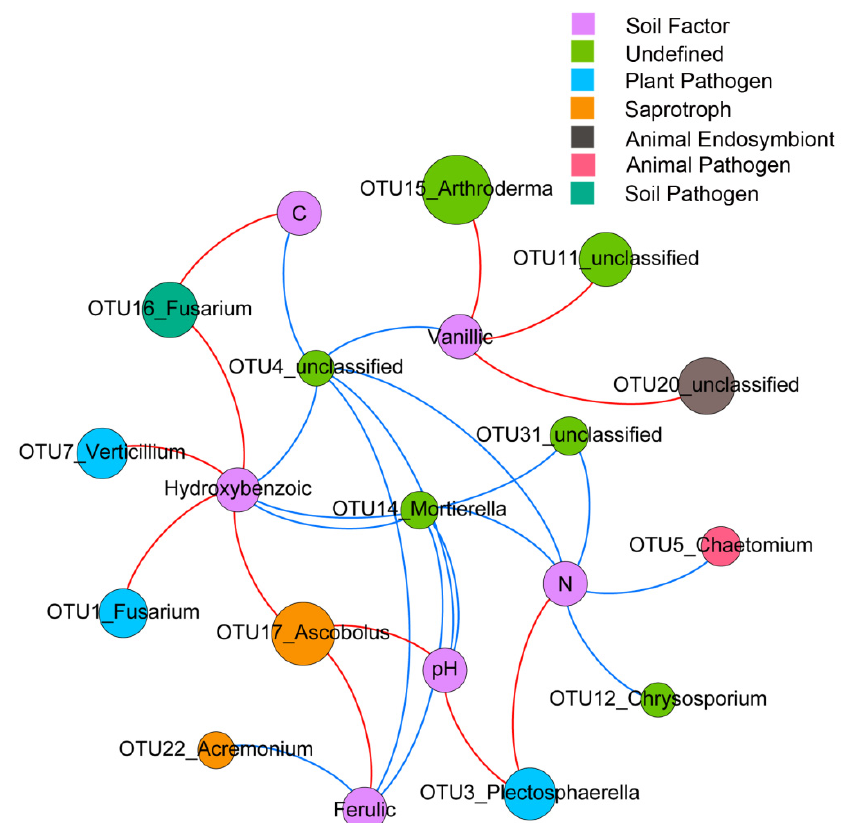
Figure 5. Network showing the soil factors in determining the abundance of dominant OTUs (top 20) by random forest analysis. The size of the circles represents the ratio of OTU relative abundance between diseased and healthy samples. The color of the circles represents the functional information predicted by FUNGuild. The green and red links represent the cases where soil factors negatively or positively affected the OTUs, respectively. Ferulic, vanillic and hydroxybenzoic represent ferulic acid, vanillic acid and p -hydroxybenzoic acid, respectively.